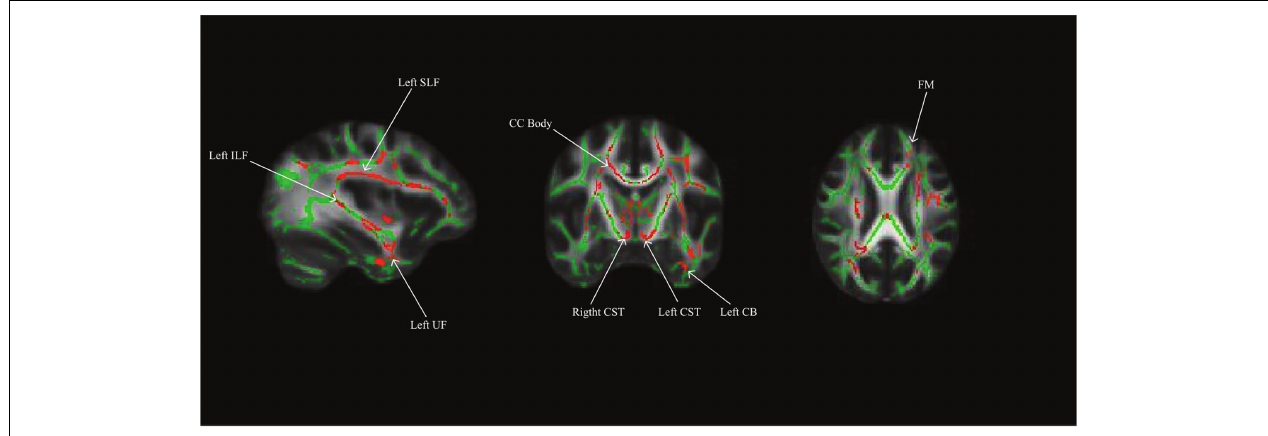
FIGURE 1 | Whole brain model results for income-to-needs ratio (INR) as a predictor of FA. Green regions indicate the FA template for the sample, and red regions indicate a significant association at p < 0.05 FWE corrected (UF, uncinate fasciculus; CB, cingulum bundle; SLF, superior longitudinal fasciculus; ILF, inferior longitudinal fasciculus; CC, corpus callosum; CST, corticospinal tract; FM, forceps minor).